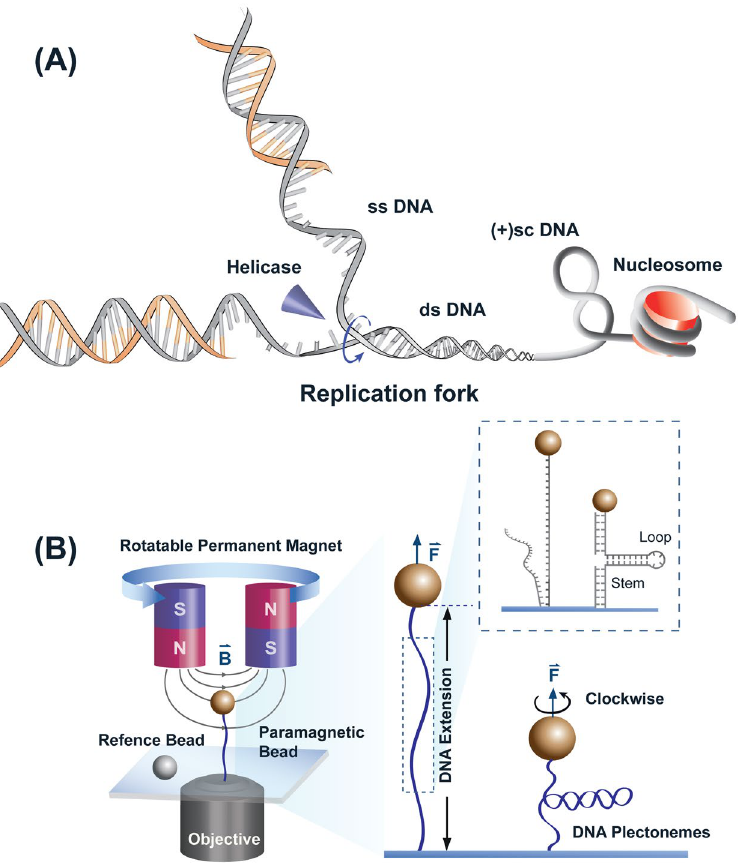
Figure 1. Schematics of DNA structures and magnetic tweezers. ( A ) Illustration of different DNA structures involved in replication fork. ( B ) Illustration of the magnetic tweezers setup. A single DNA, either torsionally unconstrained or constrained, is tethered between a glass coverslip and a paramagnetic bead. Force is applied to the molecule through the bead by an external magnetic field. For torsionally constrained DNA, the linking number is changed by rotating the magnets. Similarly, DNA constructs of ss DNA and forked DNA can be studied shown in the